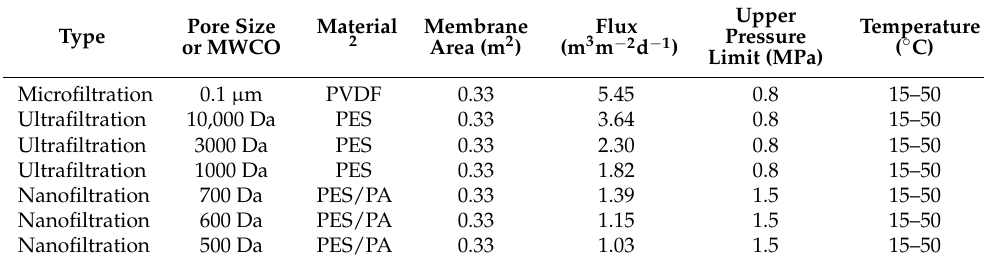
Table 1. Detailed Information of Filter Membrane 1